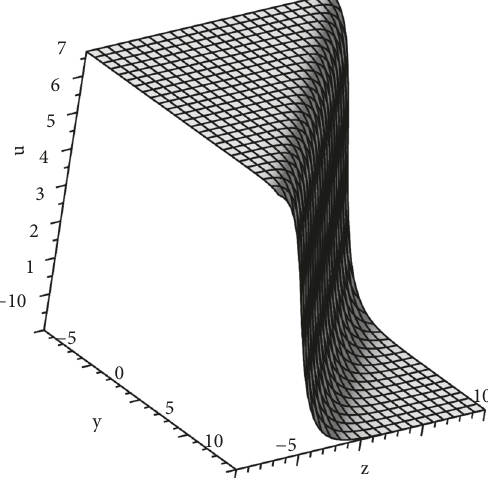
Figure 4: Kink wave profile of 𝑢 5,6 , 𝛼 = 1 , 𝛾 = 1 , 𝑑 = 0.5 , 𝑒 = 0.5 , 𝛽 = 4 , 𝑥 = 0 , and 𝑡 = 0.5